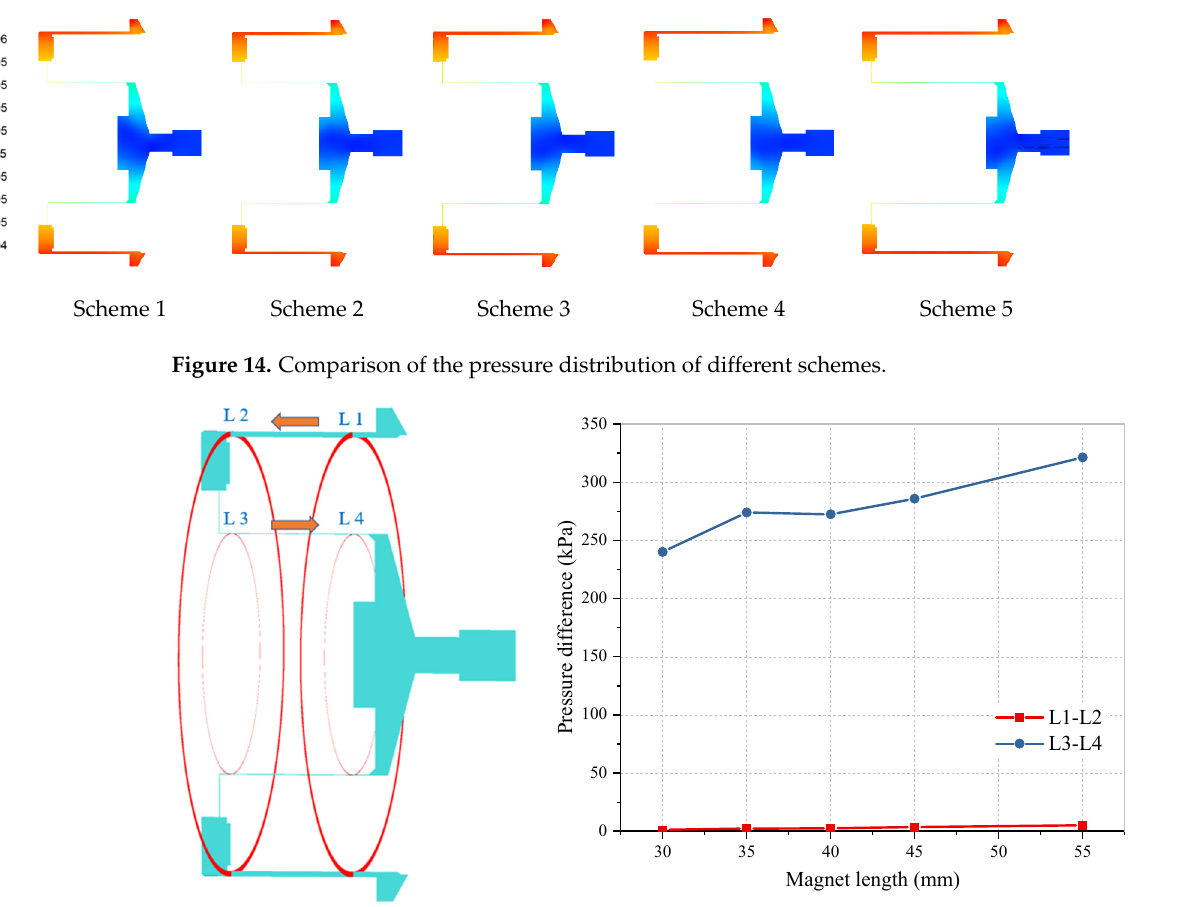
Figure 15. Gap pressure drop of the cooling circuit.